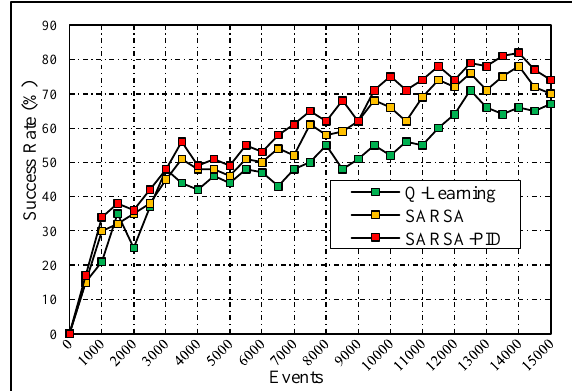
Figure. 3 . The success rate of PID Controllers for the selection of